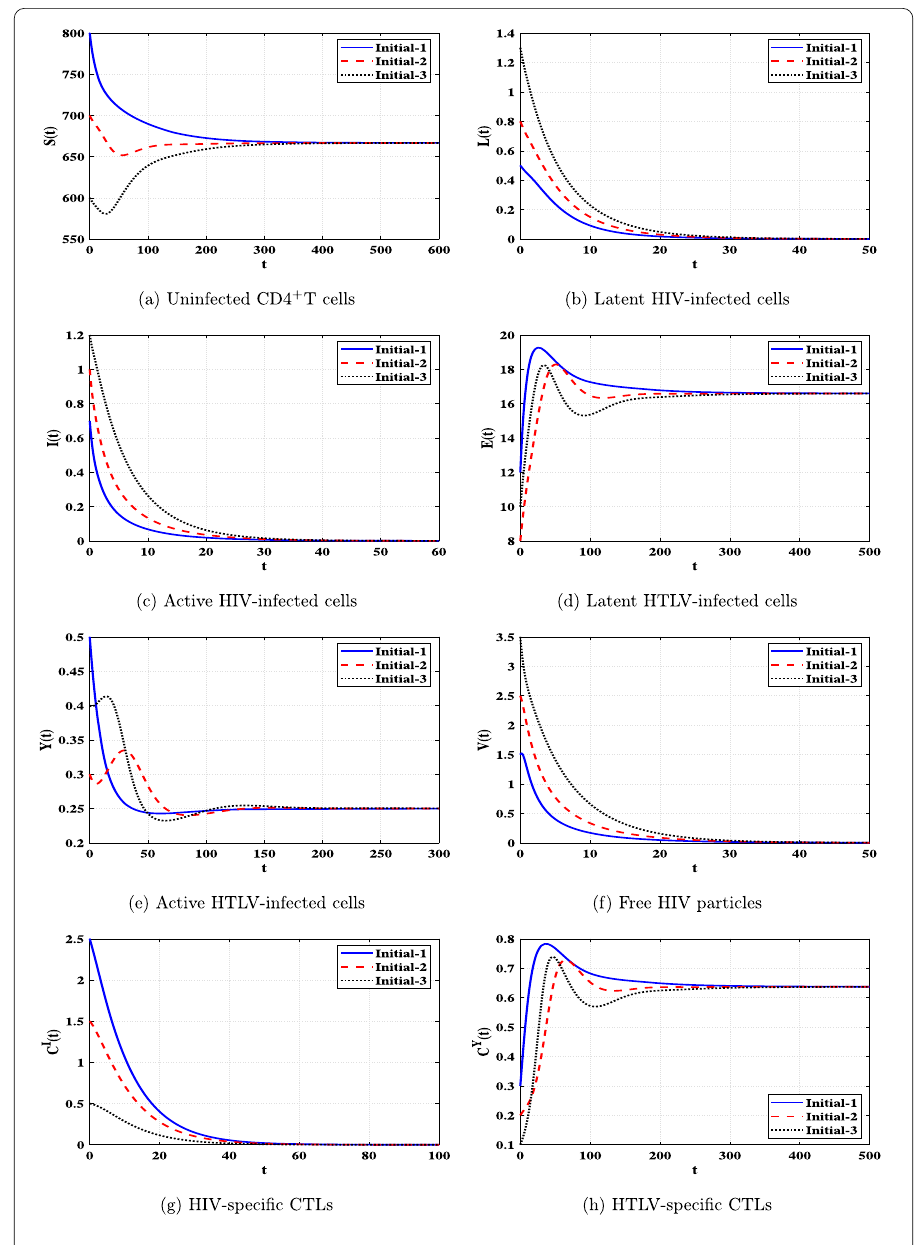
Figure 5 Solutions of system (29) when (cid:9) 4 > 1 and (cid:9) 6 ≤ 1